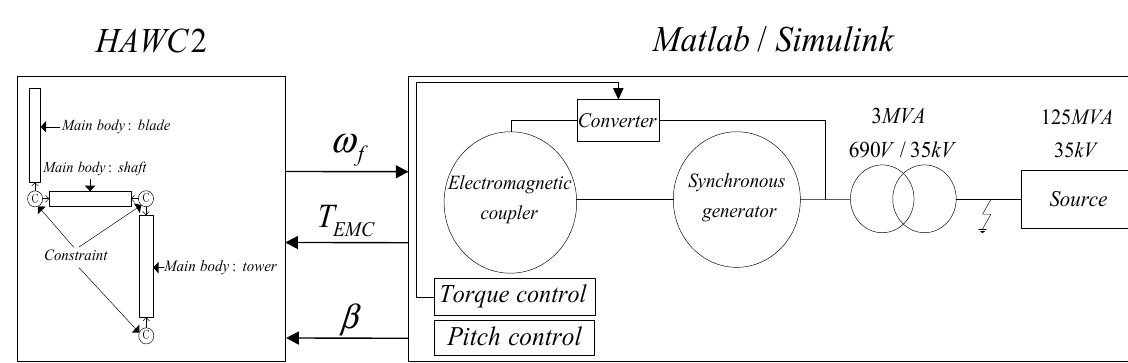
Figure 5. Schematic diagram of simulation